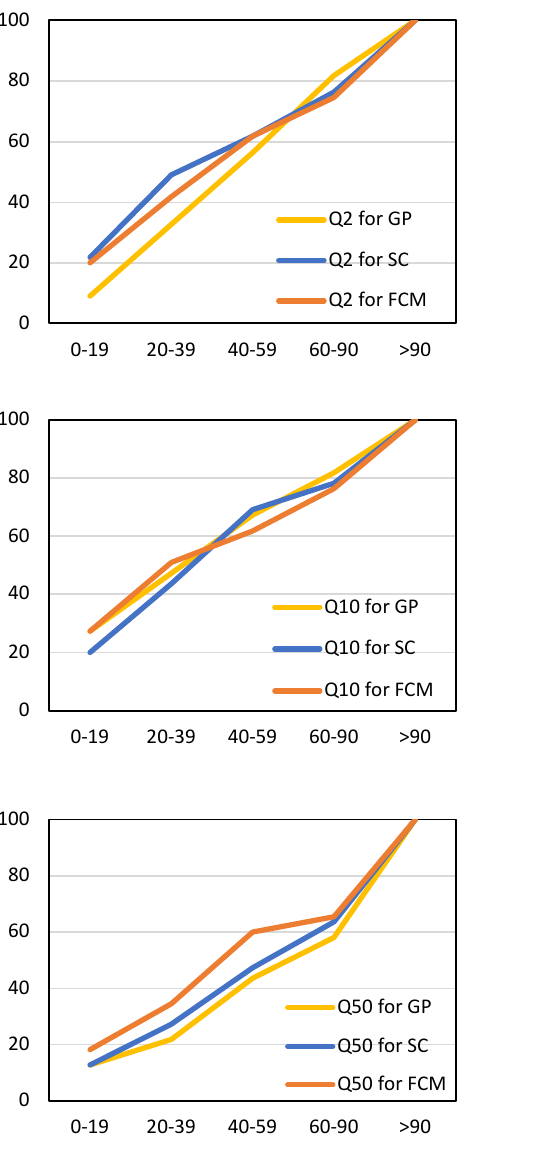
Figure 5. Plot of cumulative percentage of RE r for FCM, SC, and GP.